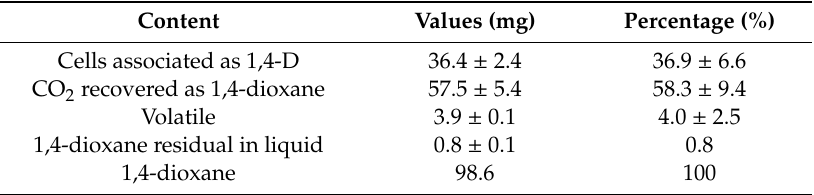
Table 1. Fate of 1,4-dioxane during biodegradation.